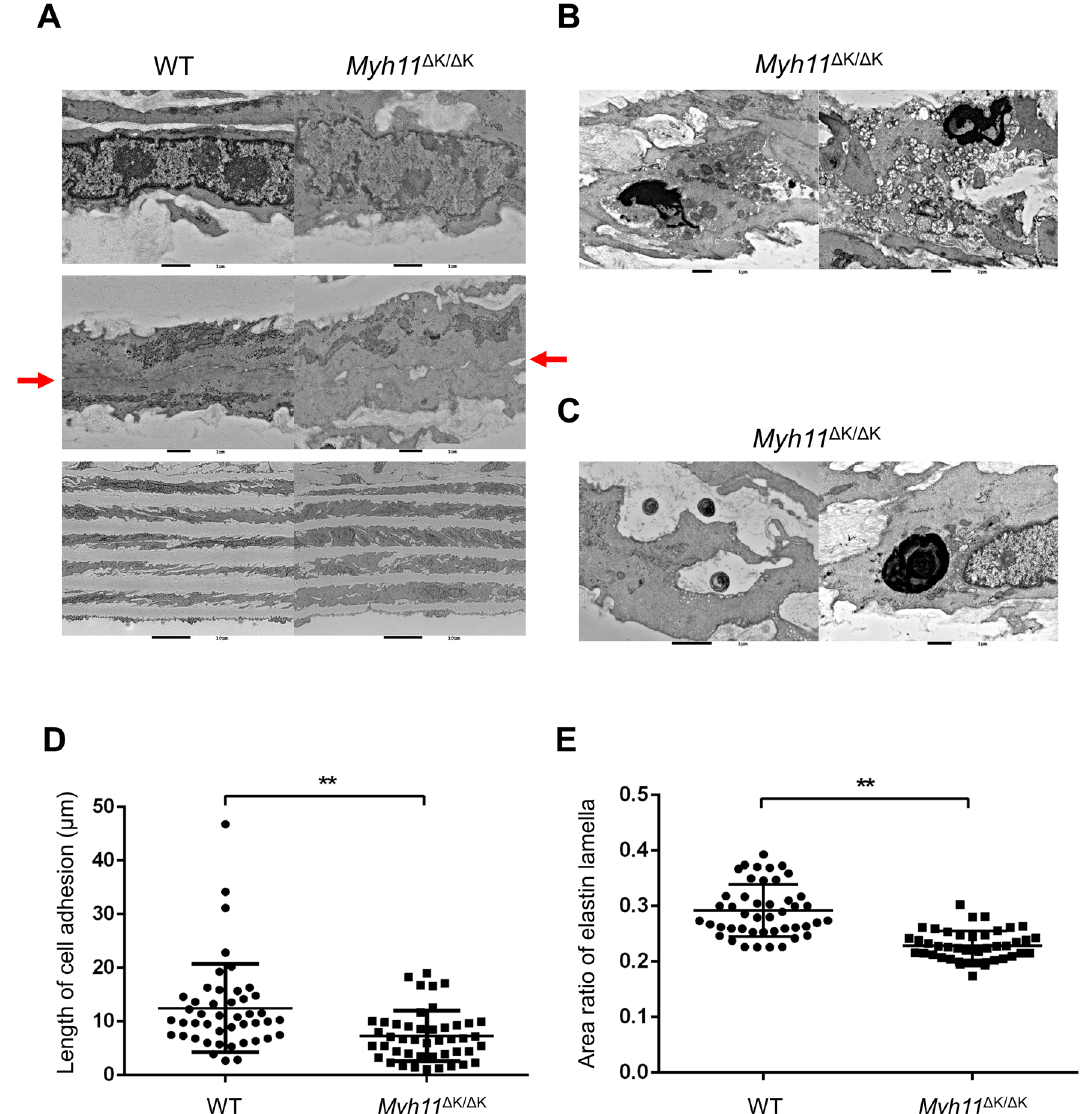
Figure 3. Large-scale electron microscopy indicated increased intracellular stress, decreased elastin lamella and attenuated cell adhesion in Myh11 ∆K/∆K aortas. (A) Electron microscopy images of WT and Myh11 ∆K/∆K+ descending aortas. Myh11 ∆K/∆K nuclei included thinner nuclear envelope and many granular components (upper row, scale bars = 1 µm, × 10,000). The adhesive faces between SMCs in Myh11 ∆K/∆K+ aortas were shorter than those in WT (middle row, scale bars = 1 µm, × 12,000). The size of the SMCs in the Myh11 ∆K/∆K+ aortas were larger than those in WT (bottom row, scale bars = 10 µm, × 2,000). (B) Debris was occasionally found in the Myh11 ∆K/∆K aortas (scale bars = 1 µm, × 10,000). (C) Myelin figures were present inside or outside Myh11 ∆K/∆K SMCs [scale bars = 1 µm, × 12,000 (left), × 20,000 (right)]. (D) The adhesive length of the SMCs in the Myh11 ∆K/∆K aorta was significantly shorter than that in WT [n = 45 (15 cells per an aortic sample), WT 12.50 ± 8.16 µm/cell vs Myh11 ∆K/∆K 7.28 ± 4.66 µm/cell, p < 0.01). (E) The area ratio of the elastic lamellae in the 50-µm section was decreased in MYH11 ∆K/∆K aortas compared to that in WT [n = 45 (15 of 50-µm sections per an aortic sample), WT 0.29 ± 0.04 vs Myh11 ∆K/∆K 0.23 ± 0.02, p < 0.01]. ** p < 0.01, Mann–Whitney U